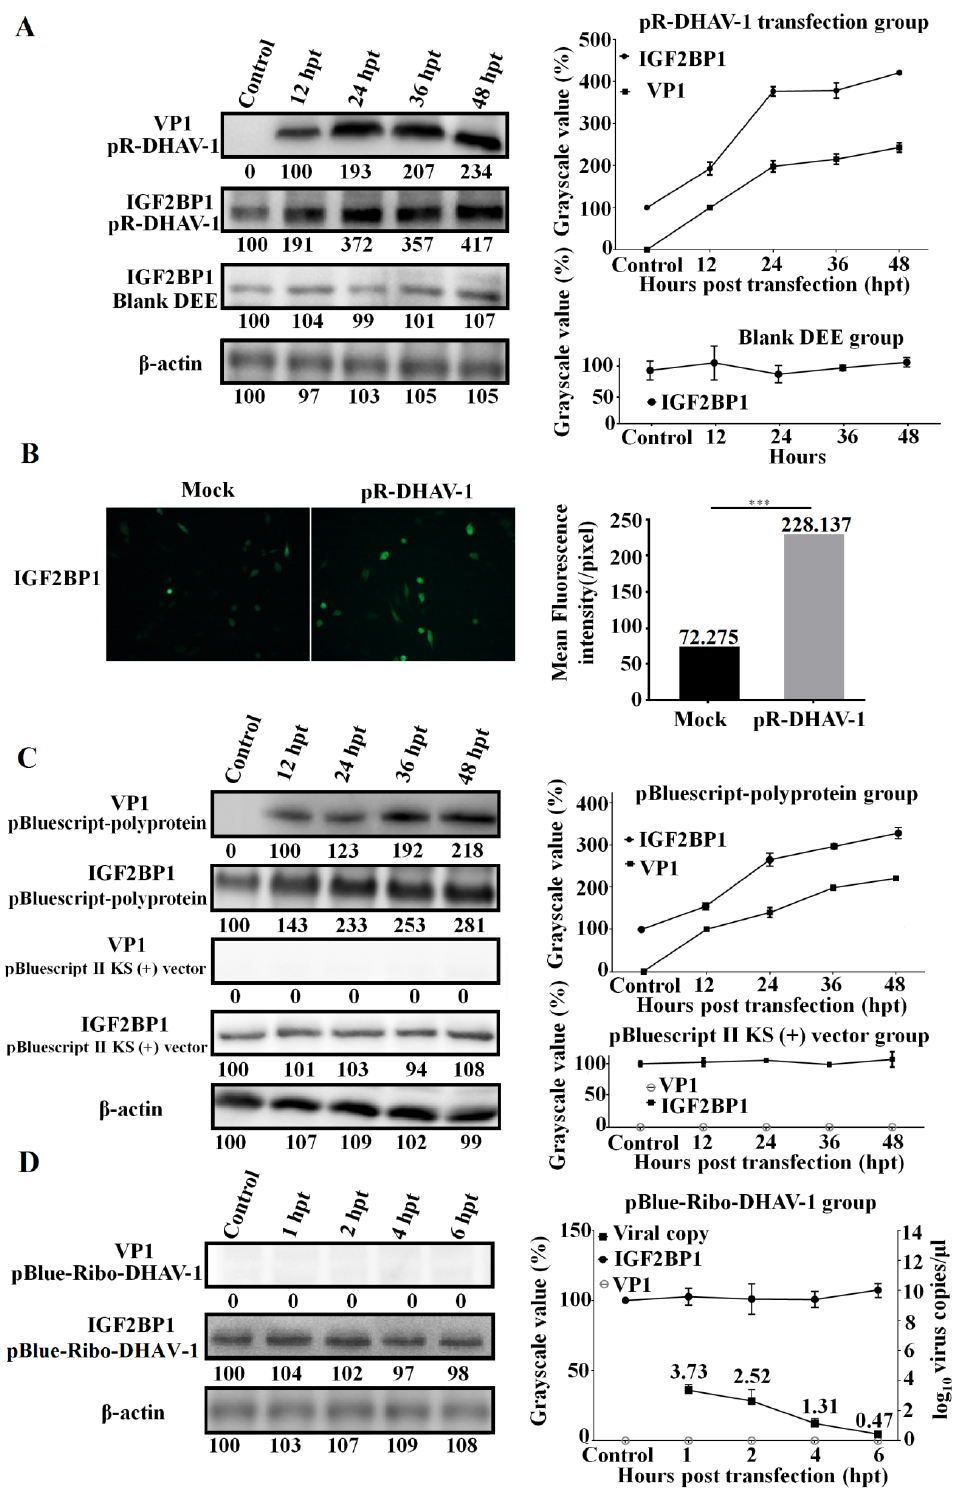
Figure 4. Viral propagation significantly enhanced IGF2BP1 expression level. ( A ) The DEE cells were transfected with 0.8 µ g of the in vitro transcribed RNA of RNA-launched infectious clone pR-DHAV-1 and were collected from 12 hpt to 48 hpt for western blot assay with anti-DHAV-1 mAb 4F8 and anti-IGF2BP1 antibody, respectively (Left). The variation tendency of the VP1 of DHAV-1 and IGF2BP1 in the transfected DEE cells was measured from 12 to 48 hpt (Right). ( B ) The IGF2BP1